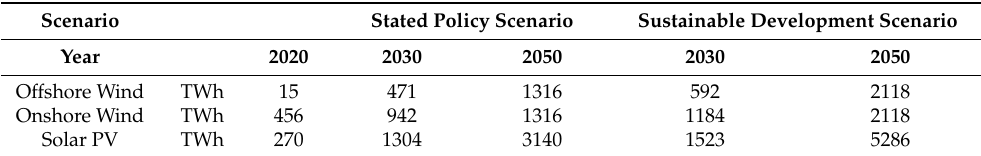
Table 6. Electricity generation from clean energy technologies in China under different scenarios (Data Source: [36]).